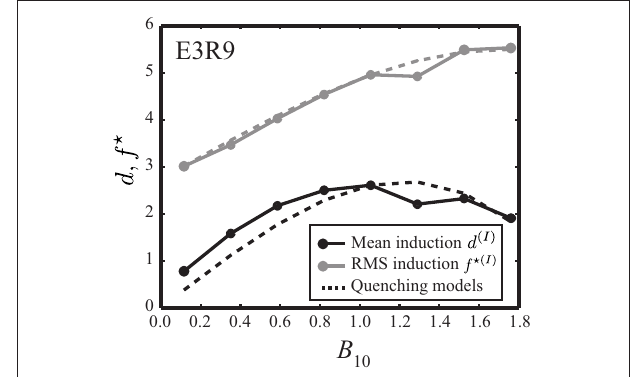
FIGURE 13 | Quenching of mean axial dipole induction d ( I ) (black) and RMS induction f ⋆ ( I ) (gray) for the dynamo model E3R9 with τ > τ c depicted in Figure 11. Dashed lines show the quadratic quenching models described in the text. All quantities in dimensionless units.